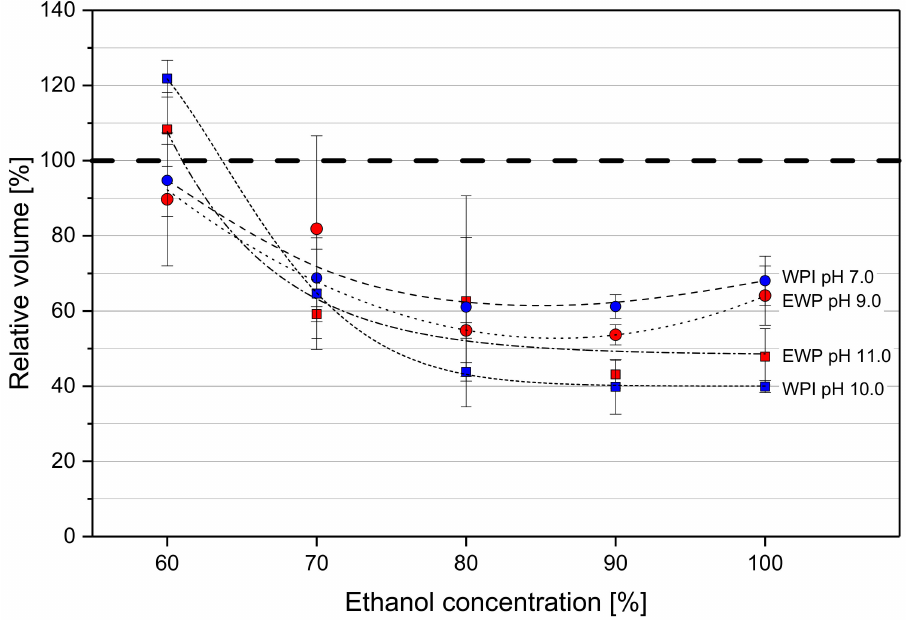
Figure 1. Relative volume of gel sphere samples after immersion in the respective aqueous ethanol (EtOH) solution. WPI gel samples are marked in blue, and EWP samples are red. Circles represent the native pH, squares represent alkaline conditions. Dashed lines are a guide to the